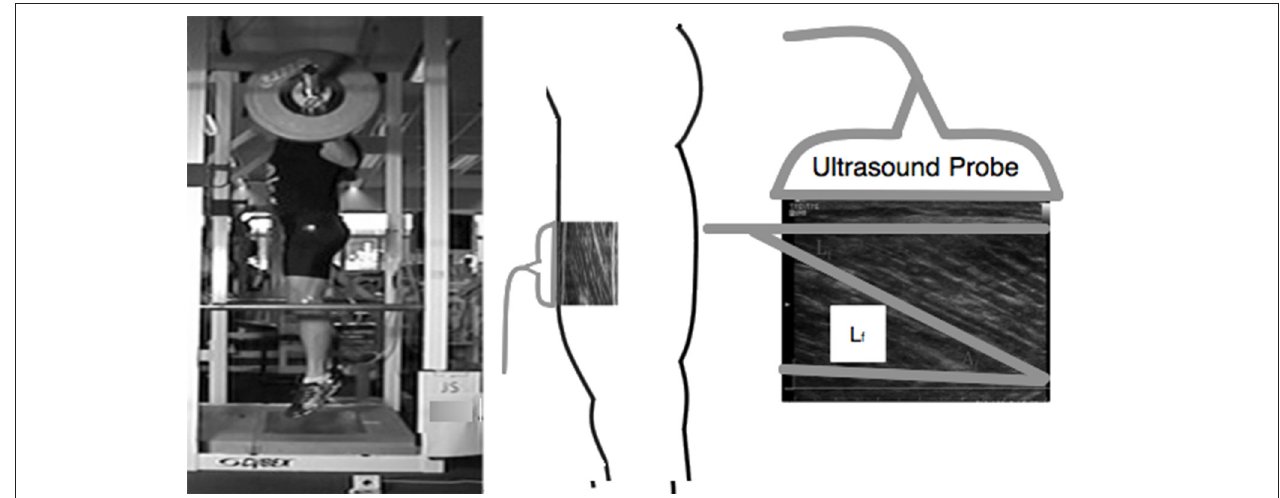
FIGURE 1 | Example of experimental design depicting how VL fascicle length was measured and extrapolated during a jump squat.